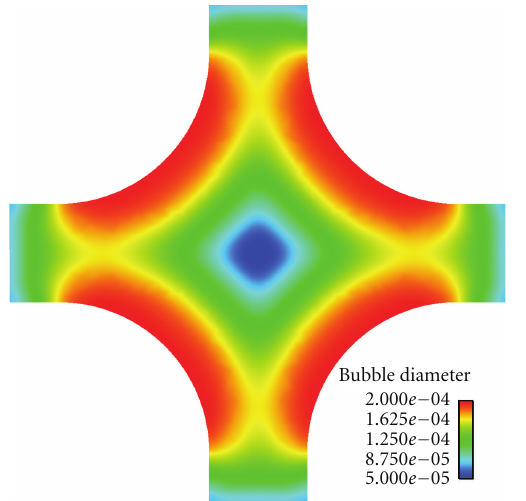
Figure 17: Void-fraction distribution at the measuring section for run 1.4325 by using the Yao-Morel model.